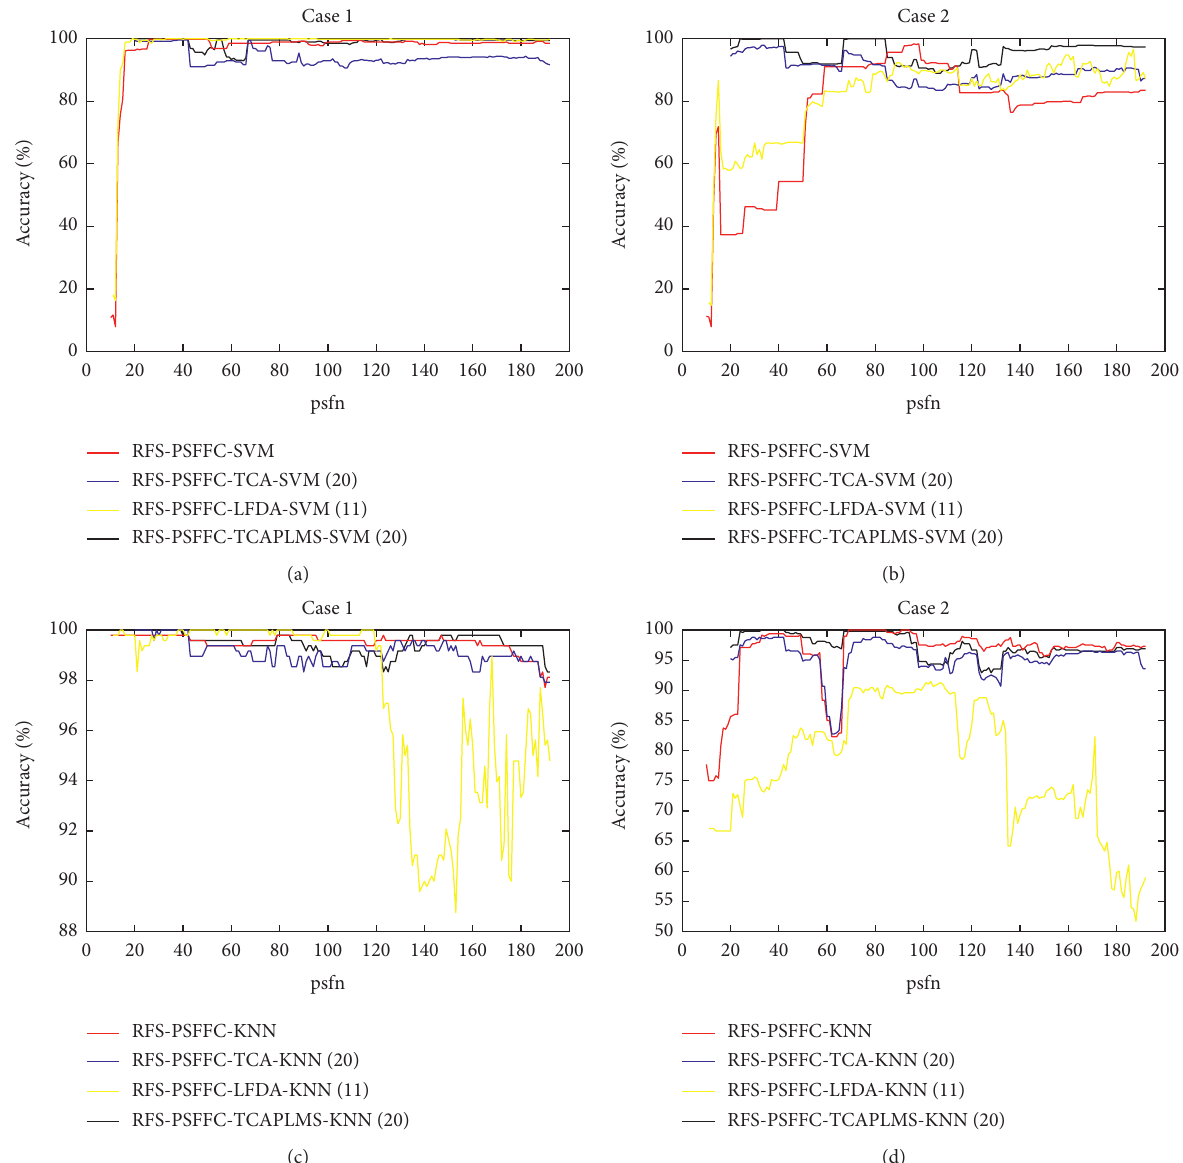
Figure 22: The testing accuracies of models with the use of PSFFC, TCA, LFDA, and TCAPLMS, respectively.